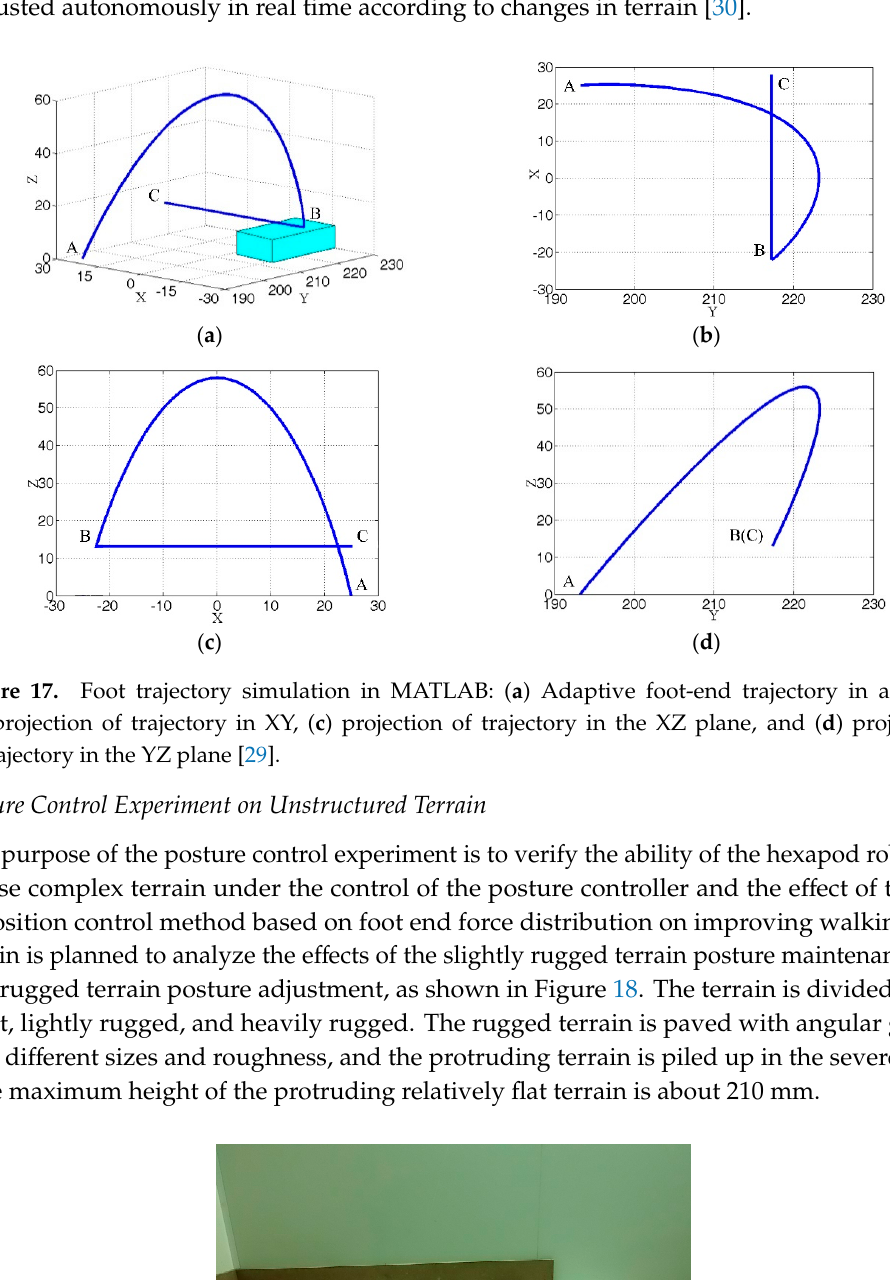
Figure 16. Curve of angles of posture.